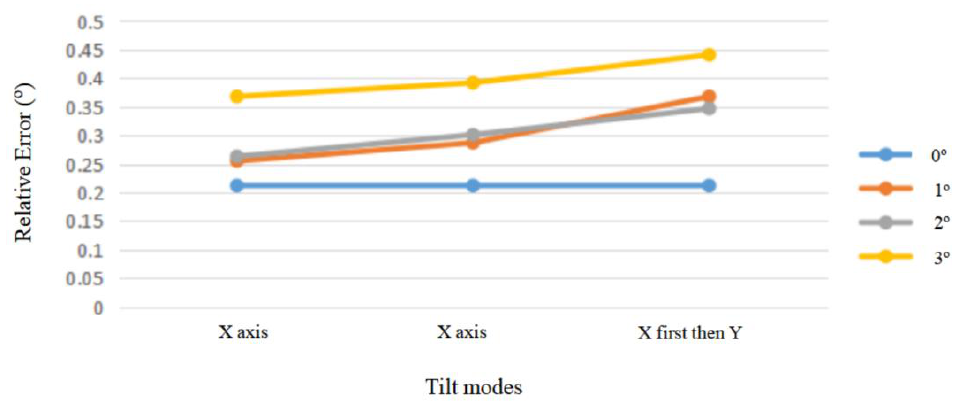
Figure 14. Relative error diagram of different tilting modes.